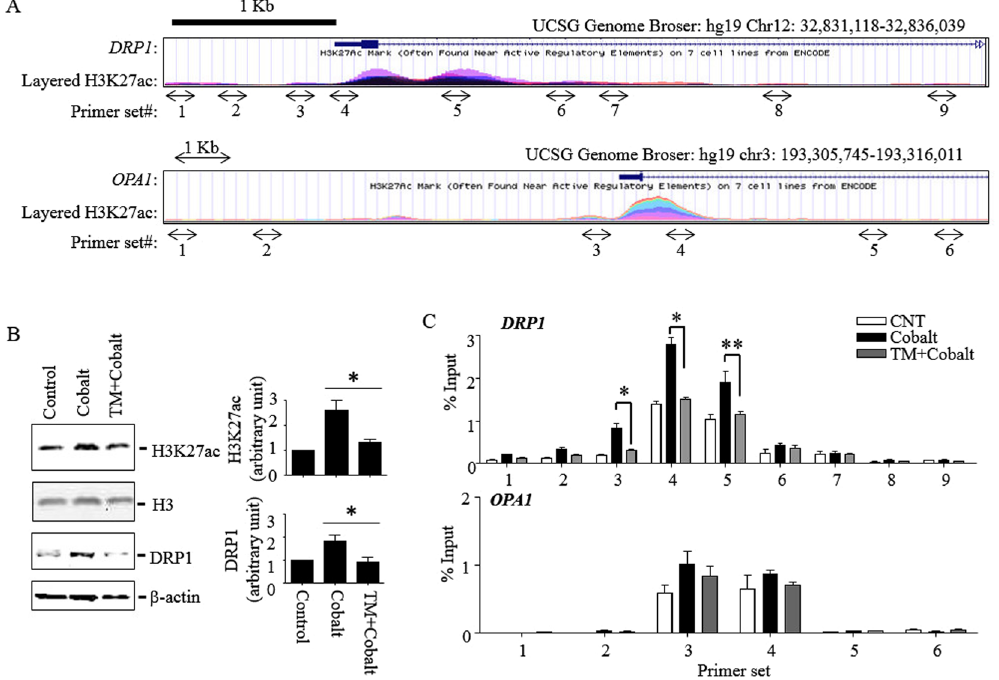
Figure 7. TM inhibits cobalt-induced DRP1 expression and decreases the level of H3K27ac association with the DRP1 promoter. ( A ) Snapshot images of the ENCODE ChIP-sequence database showing the human DRP1 and OPA1 promoter regions and H3K27ac association. Arrows indicate locations of primer sets used for H3K27ac ChIP-qPCR analysis. ( B , C ) HK-2 cells were exposed to cobalt (300 µ M) for 7 h and total cell lysates were extracted as described in “ Methods ”. ( B ) H3K27 acetylation levels and DRP1 expression were measured by Western blots using anti-H3K27ac and DRP1 antibodies (left panel). Immunoblots against H3 and β -actin were used as loading controls. H3K27ac and DRP1 band intensities were analyzed by NIH images J program (right panel). Data were shown as mean ± S.D. (n = 3; * p < 0.05; Student’s t -test). ( C ) H3K27ac